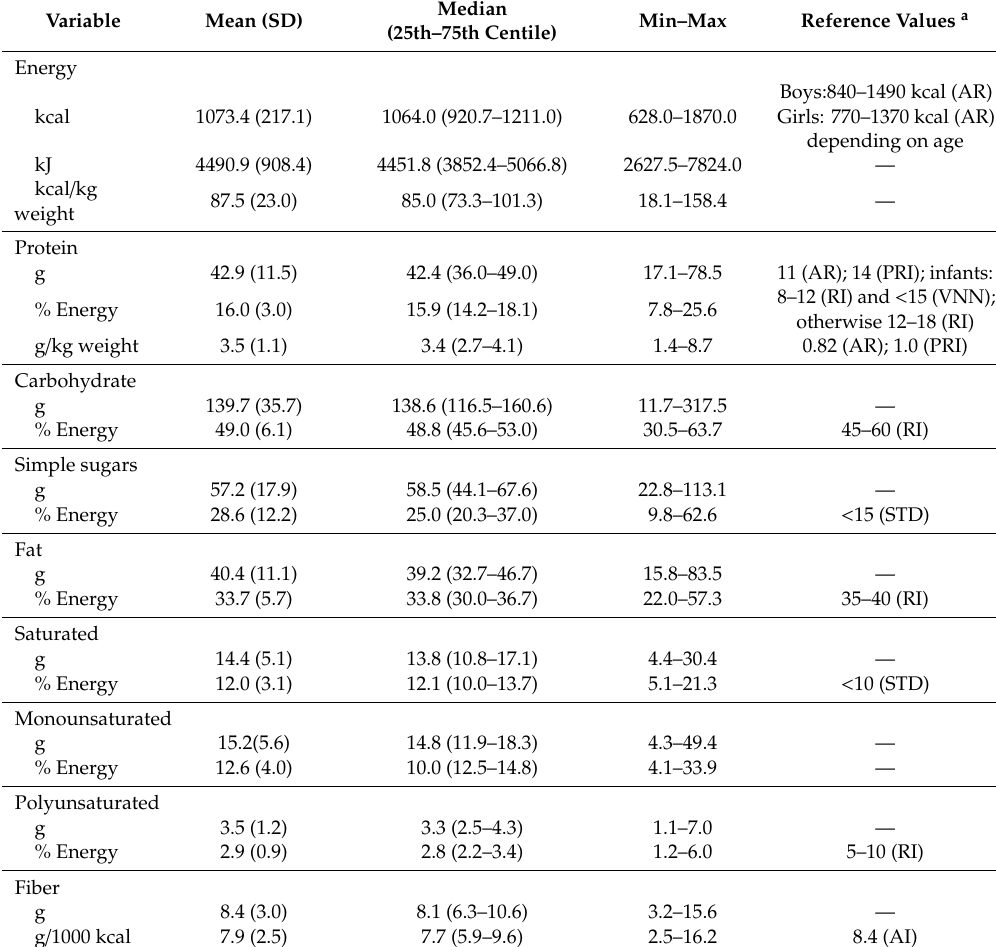
Table 4. Daily dietary intake of energy, macronutrients, and fiber, in infants / children aged 1 ≤ years < 4 ( n = 148).